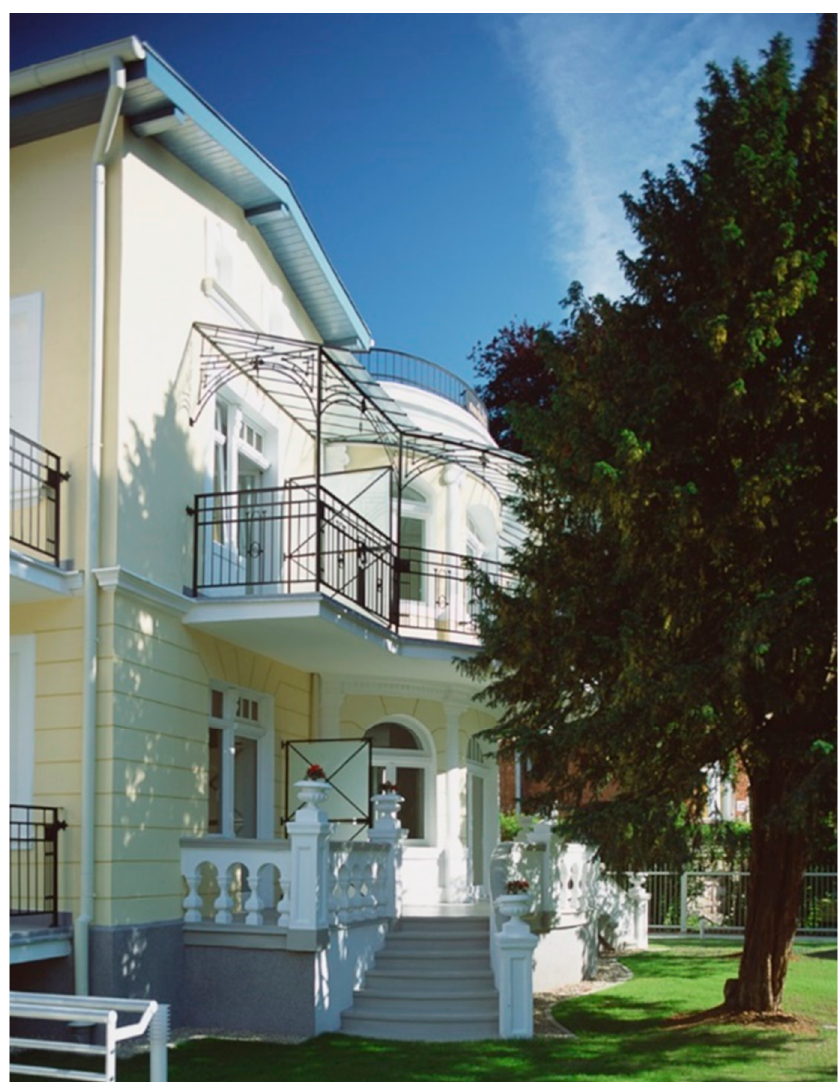
Figure 16. The historical part of Willa Halina. Front elevation after revitalization. Source: FORT Taraszkiewicz Architekci.